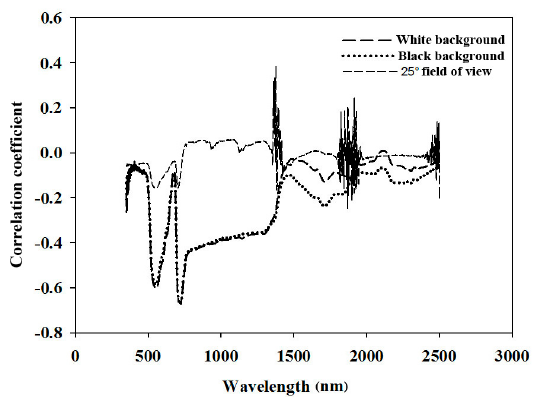
shown in Figure 3. Sensors 2017 , 17 , 538